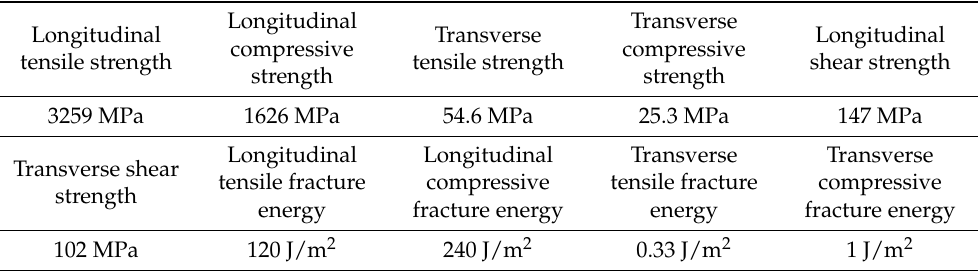
Table 6. Detailed values of the parameters used in the Hashin model.